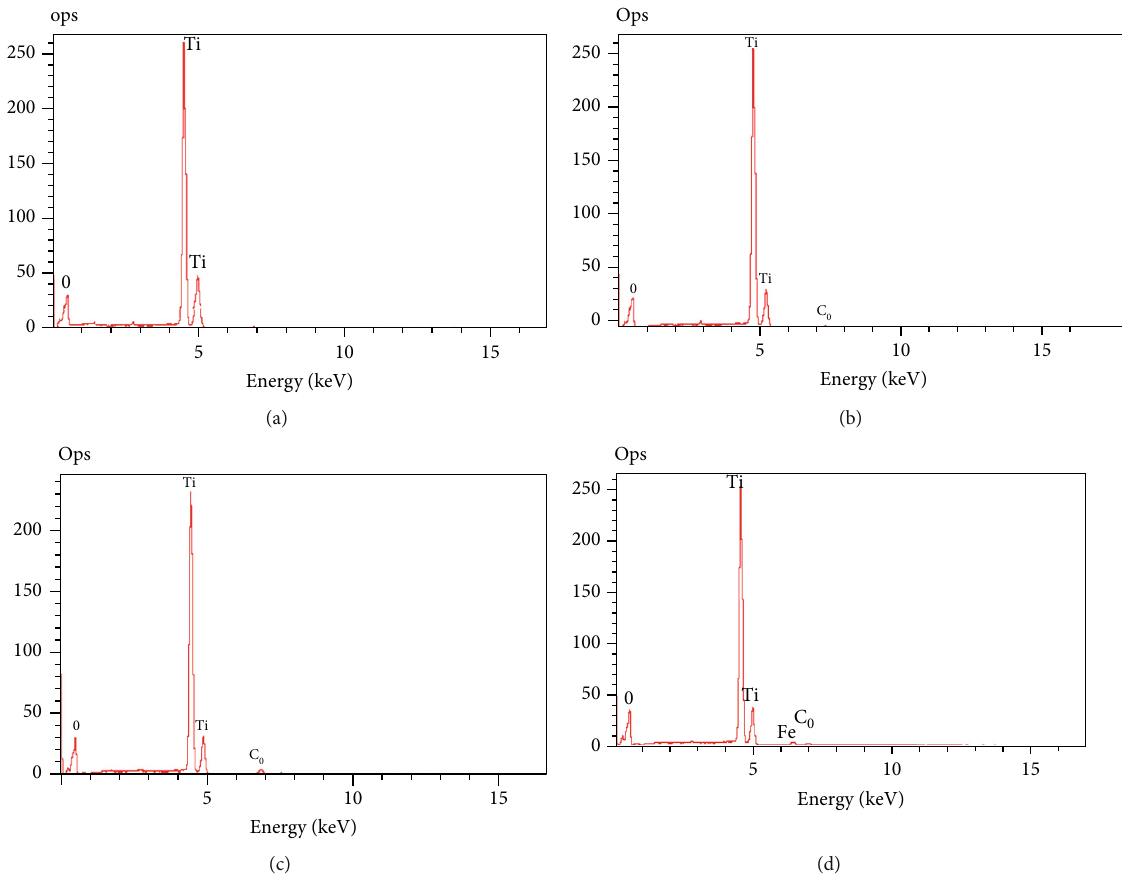
Figure 3: EDXS spectra of (a) undoped TiO